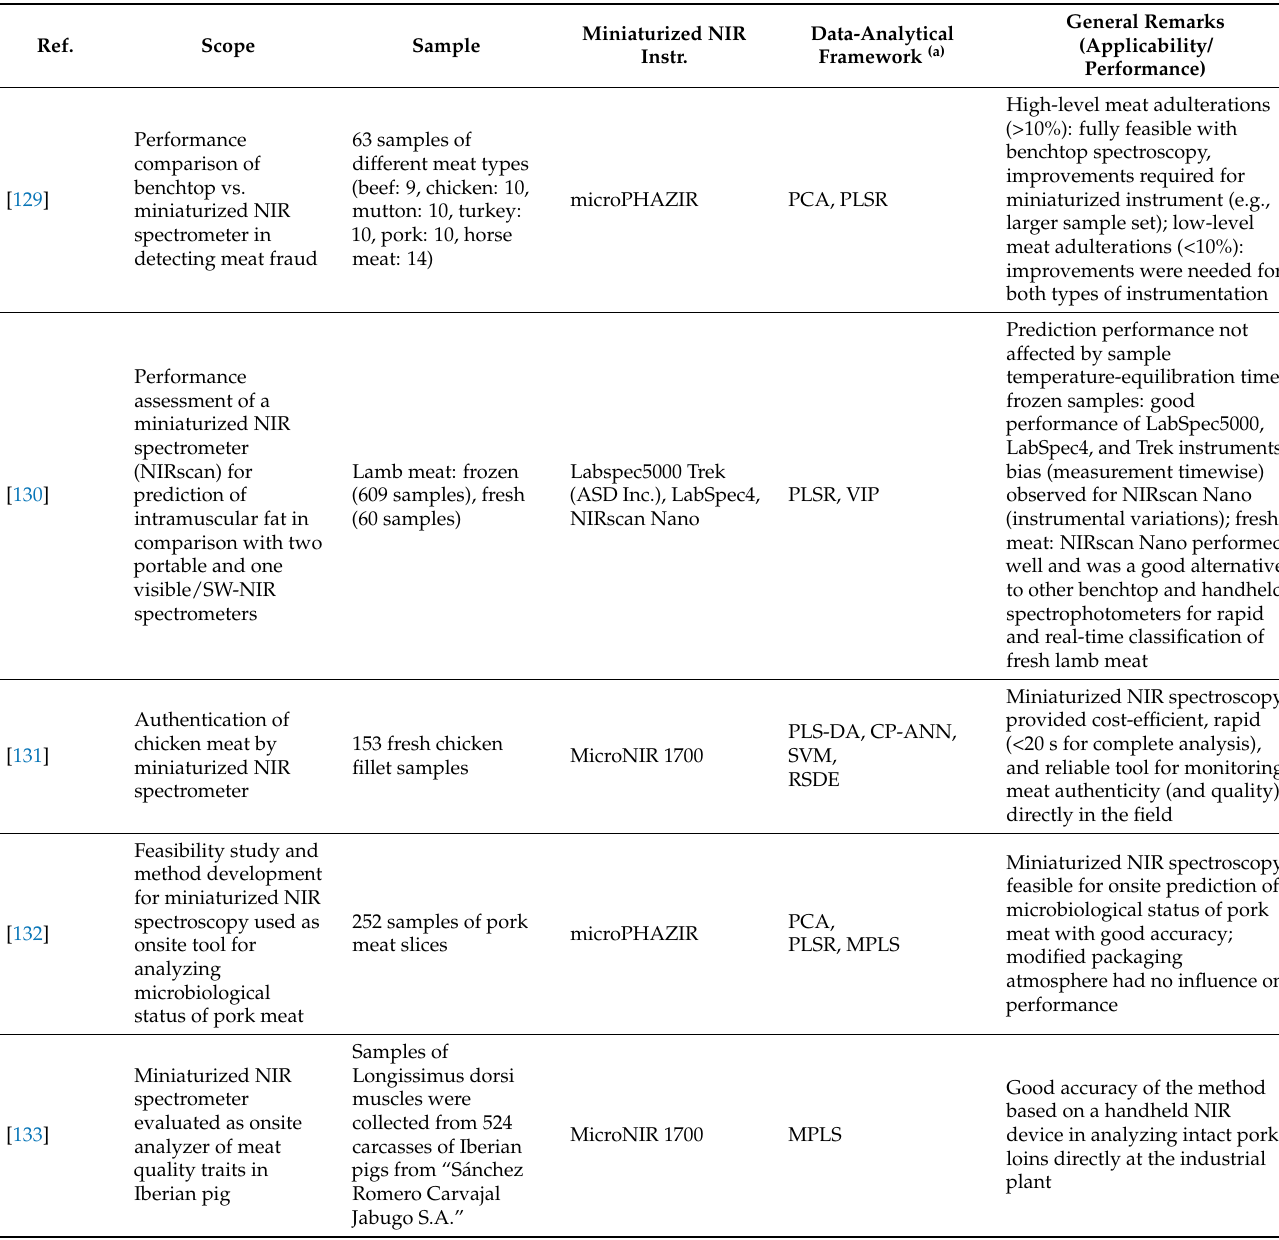
Table 5. Recent research activity oriented toward miniaturized NIR spectroscopy in the area of meat